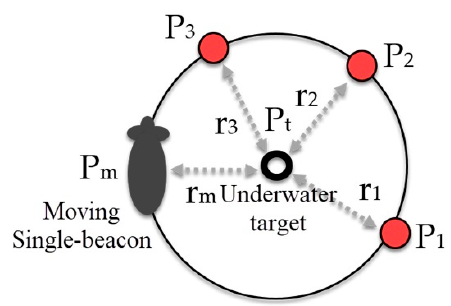
/ Single-beacon positioning of a fixed target from a moving Figure 8. Range-only/Single-beacon positioning of a fixed target from a moving vehicle. Figure 8. Range-only